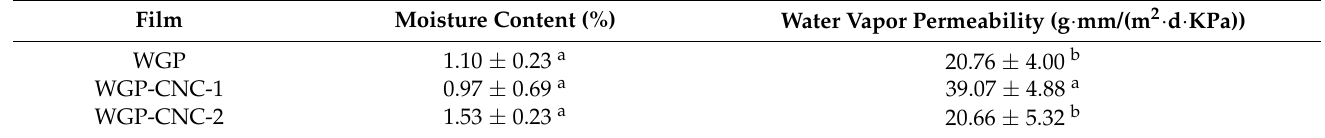
Table 6. The moisture content and water vapor permeability of WGP-based films with different adding amounts of CNC (CNC-1: 0.25%; CNC-2: 5%). Different letters (a–c) in the same column indicated significant differences ( p <